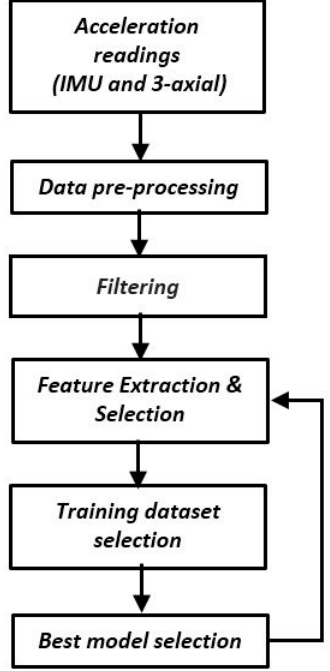
Figure 1. Iterative architecture for multiclass